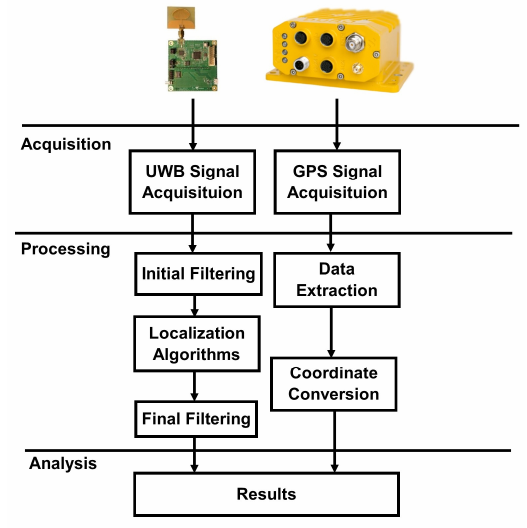
Figure 5. A detailed diagram of the data processing.